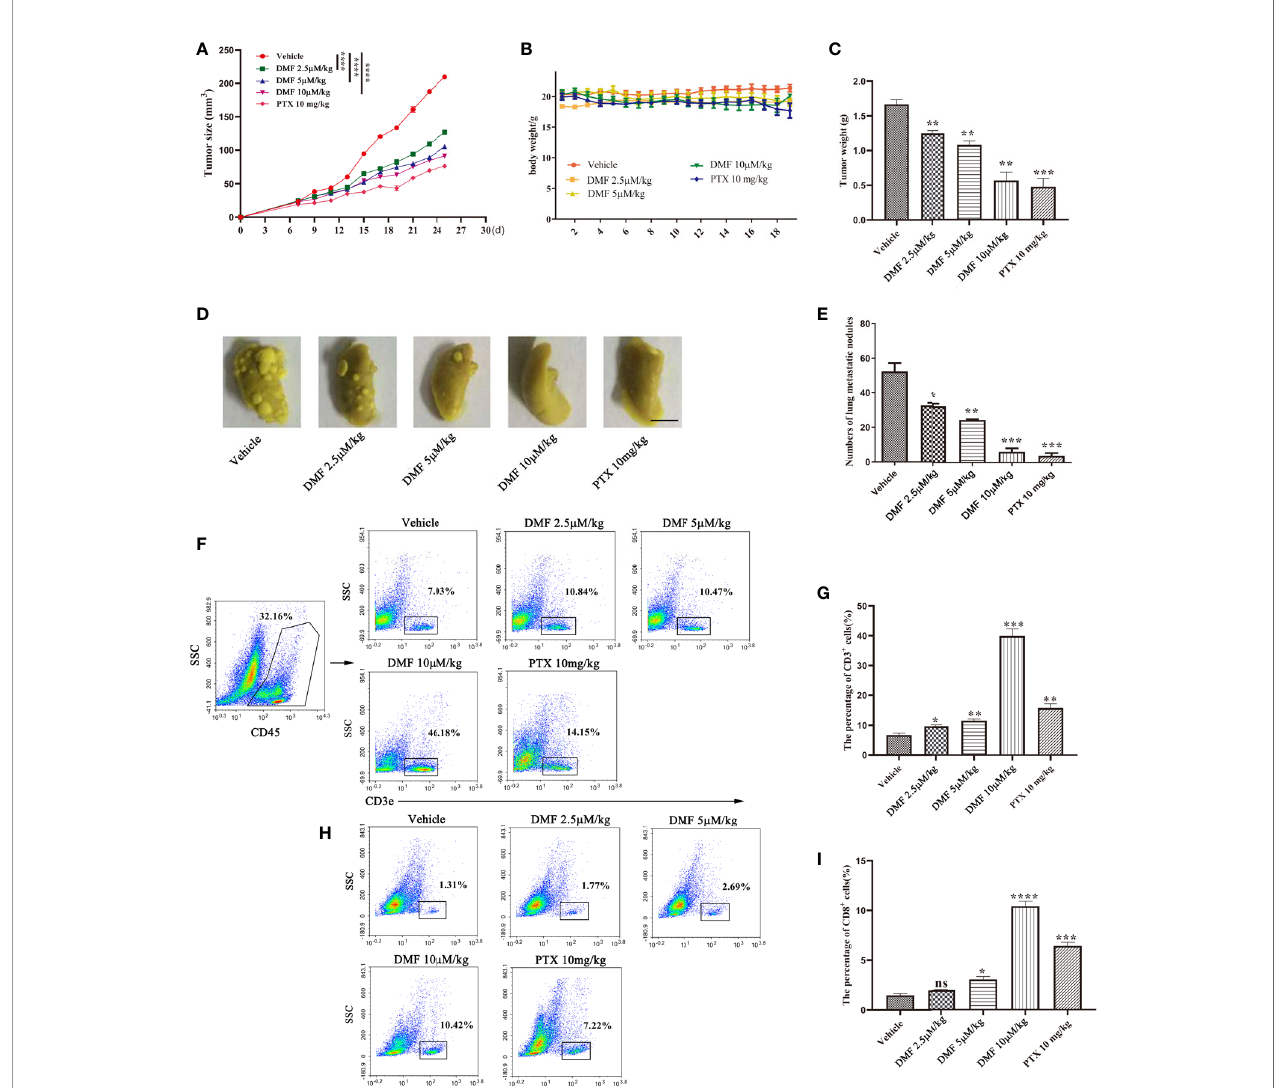
FIGURE 3 | DMF inhibits tumor growth and metastasis in 4T1 orthotopic inoculation model of breast cancer. (A) Tumor growth of mice in each group was analyzed by measuring the volume every 2 days (n = 5). (B) Weight of each group of mice was measured once every two days (n = 5). (C) The tumor weight of each group of mice was analyzed (n = 5). (D, E) resection of lung tissue and counting of nodules to evaluate the anti-metastasis effect of oral DMF. Scale bar, 250 mm. (F, G) Flow cytometry analysis and quanti fi cation of CD3 + T cells in the tumor microenvironment of each group. (H, I) Flow cytometry analysis and quanti fi cation of CD8 + T cells in the tumor microenvironment of each group. Data are presented as the mean ± SEM. ns, no signi fi cance. * P < 0.05, ** P < 0.01, *** P < 0.001, **** P < 0.0001 as determined by the one-way ANOVA